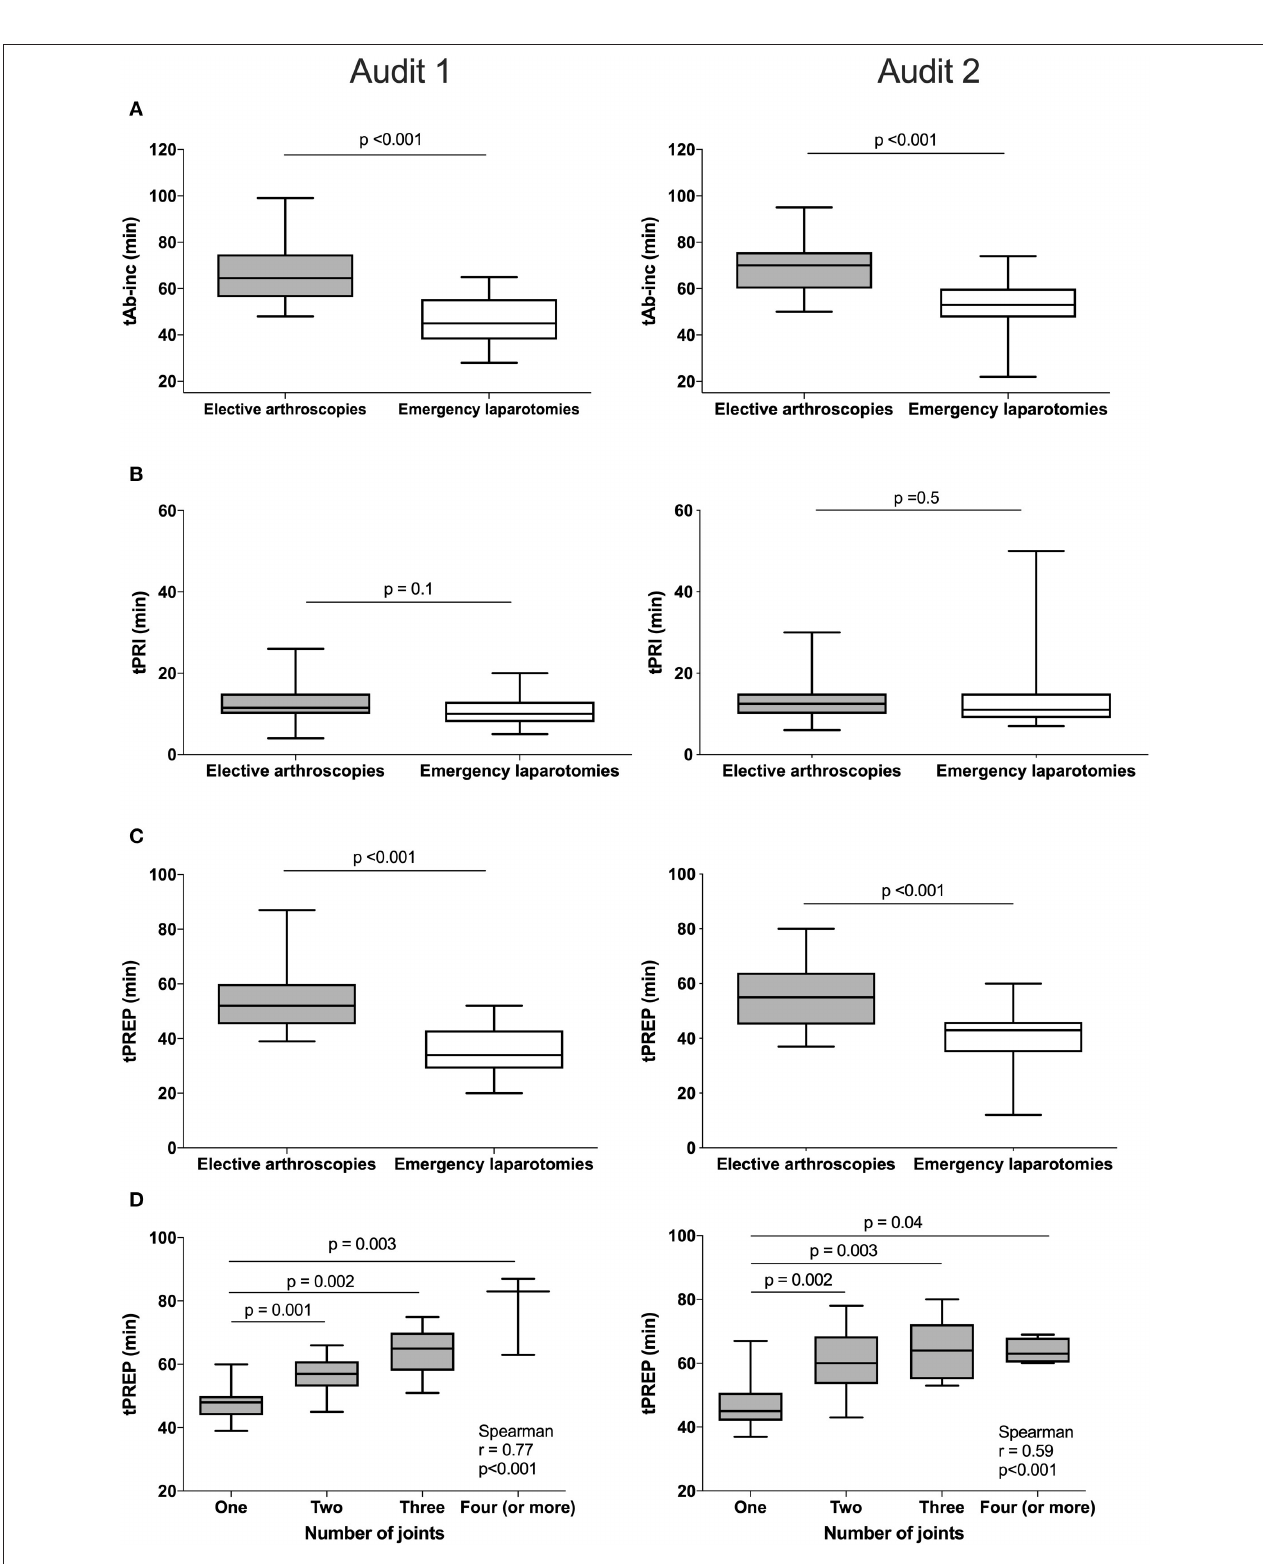
FIGURE 2 | Differences in timings between elective arthroscopies and emergency laparotomies during audit 1 (left column) and audit 2 (right column) and the influence of arthroscopy joint number on preparation time. Data are expressed as median and ranges. The median antimicrobial dosing to surgical incision time (tAB-Inc) was significantly longer in elective arthroscopies than emergency laparotomies (both audits, row A ). No significant differences in the pre-induction phase